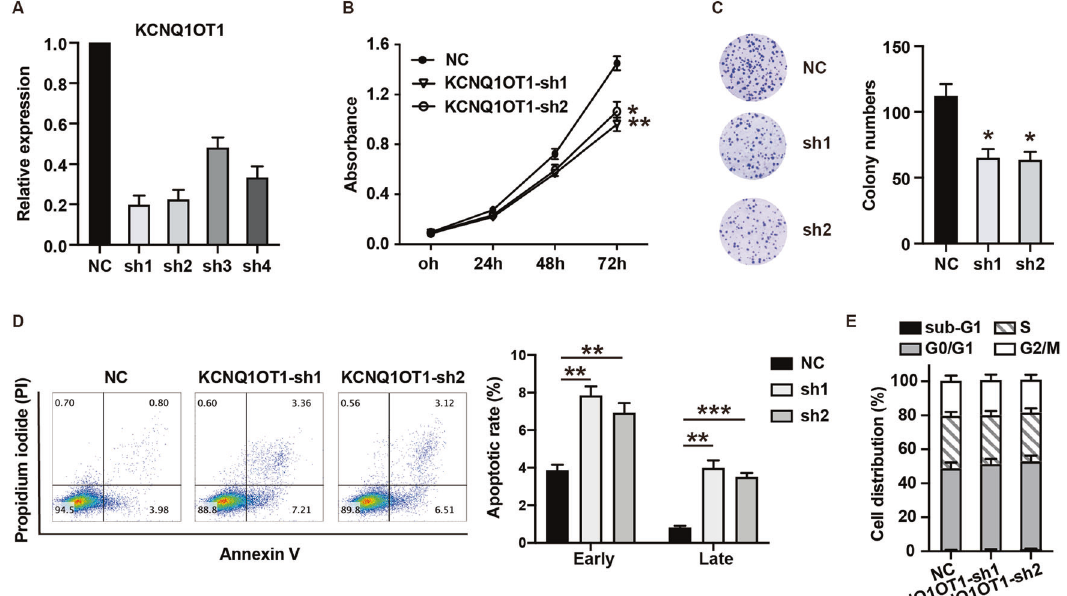
Fig. 2 Highly expressed KCNQ1OT1 promotes APL cell proliferation. A Four shRNAs were used to silence KCNQ1OT1 in NB4 cells. The expression of KCNQ1OT1 was determined in NB4 cells transfected with pLVX-shRNA2-derived lentiviruses carrying shRNAs speci fi cally targeting KCNQ1OT1. B CCK8 assays were performed to determine the viability of NB4 cells transfected with KCNQ1OT1-sh1, KCNQ1OT1-sh2, and negative control (NC). C Colony formation assays were performed to test the proliferation of KCNQ1OT1-shRNA-transfected NB4 cells. Colonies were captured and counted. D Cell apoptosis was analyzed by fl ow cytometry. Lower Right: early apoptotic cells (Early), Upper Right: late (or terminal) apoptotic cells (Late). E Cell cycle distribution was determined by fl ow cytometry. The result is presented with the means ± SEM of three independent experiments. * p < 0.05, ** p < 0.01, *** p <